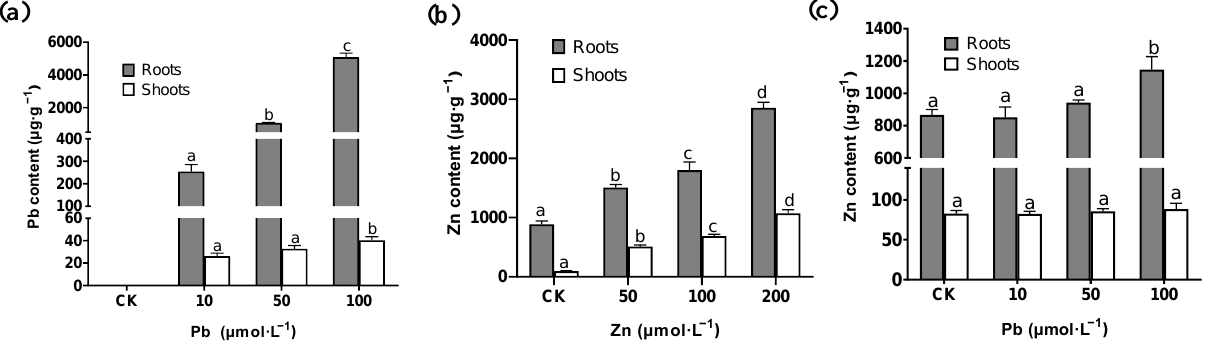
Figure 1. Shoot height ( a , b ) and root length ( c , d ) of M. cordata grown hydroponically under control (CK) and varied concentrations of Pb and Zn for seven days. Values are means ± SE ( n = 3) with three separate replicates. Means denoted by different letters refer to the significant differences ( p < 0.05, Duncan’s test).